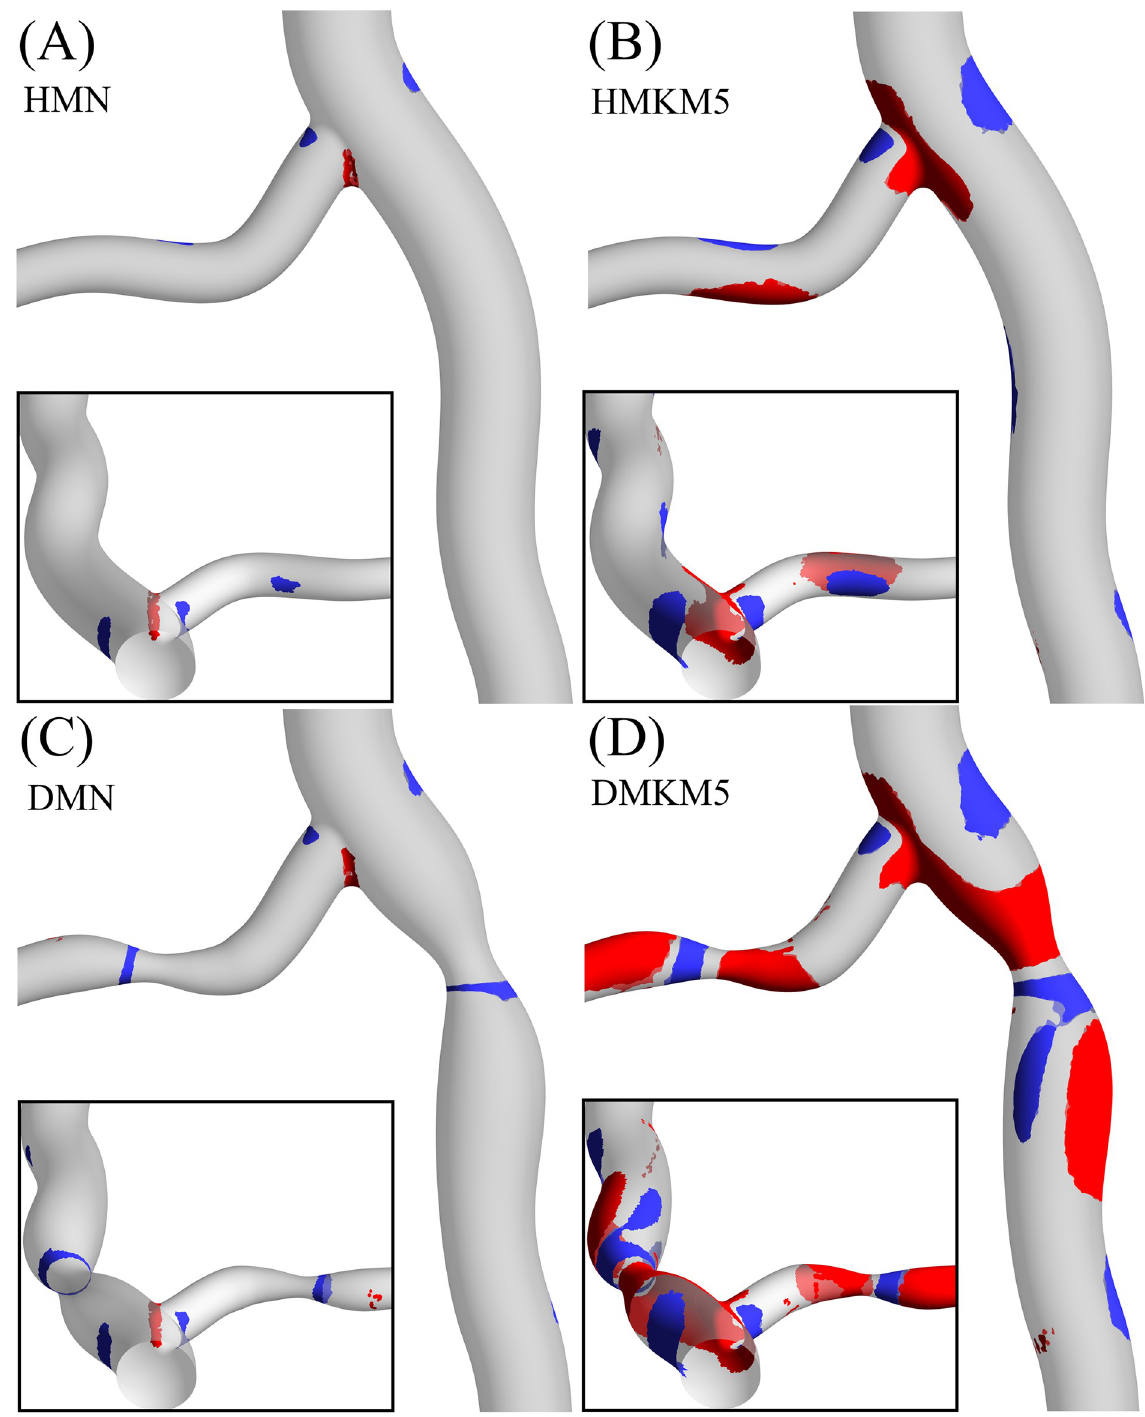
Fig 9. Red and blue iso-contours indicating regions of high ( > 0.5) and low ( < 0.4) TA hematocrit, respectively, for the healthy Multi- Newtonian (A) and Multi-MKM5 (B) models, and for the diseased Multi-Newtonian (C) and Multi-MKM5 (D) models, with reverse views